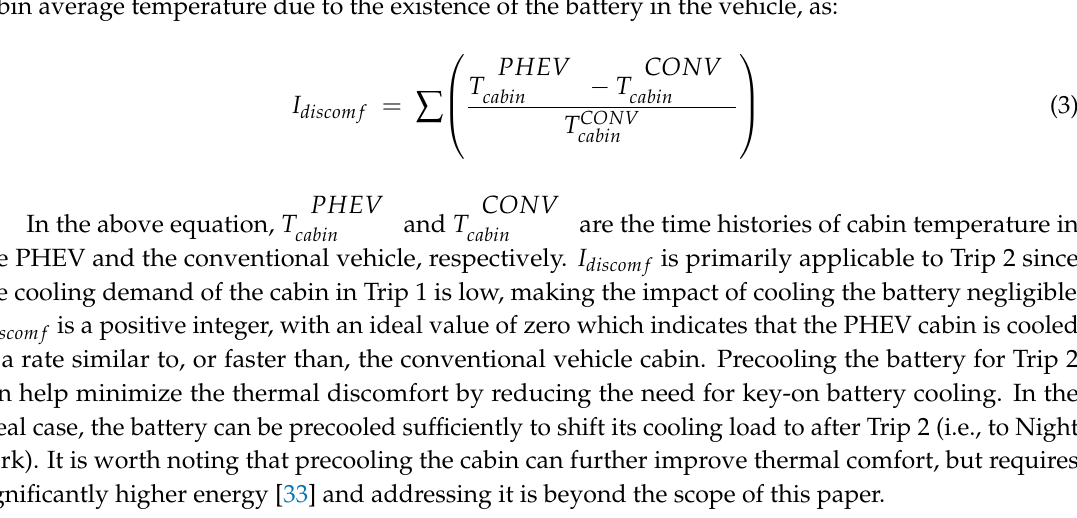
Figure 6. Effect of the battery on the thermal conditions of the cabin after hot soak (Trip 2): ( a ) the absolute cabin; ( b ) temperature offset.